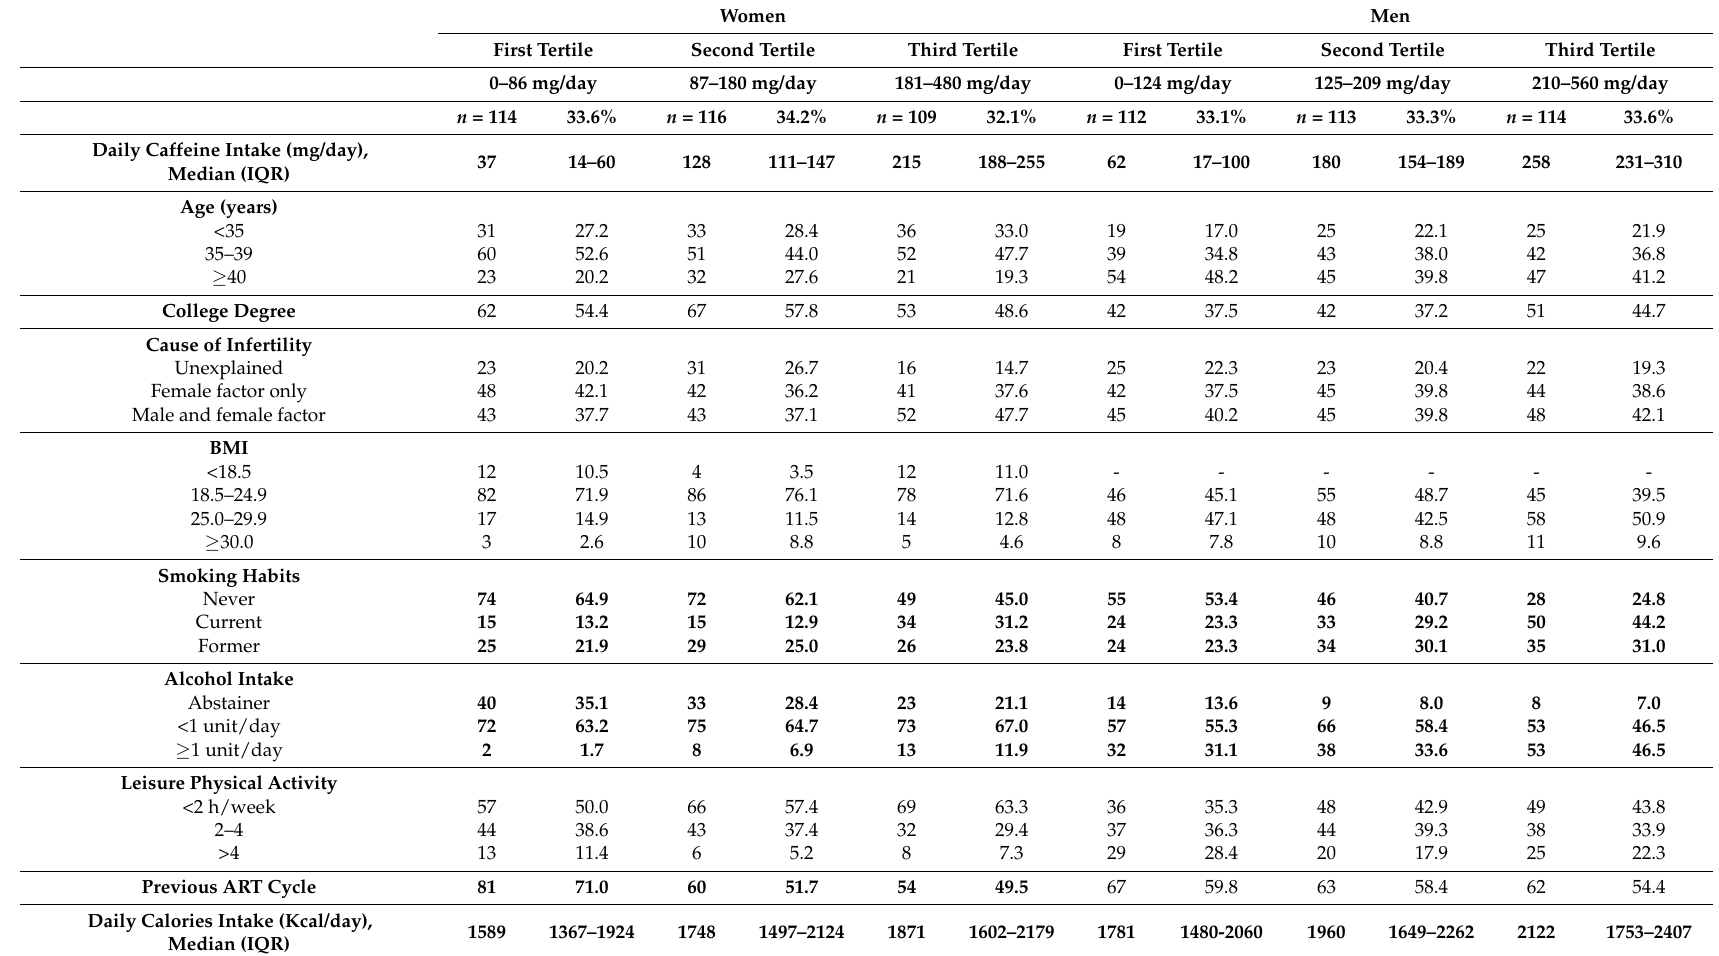
Table 1. Demographic characteristics of 339 couples, according to caffeine